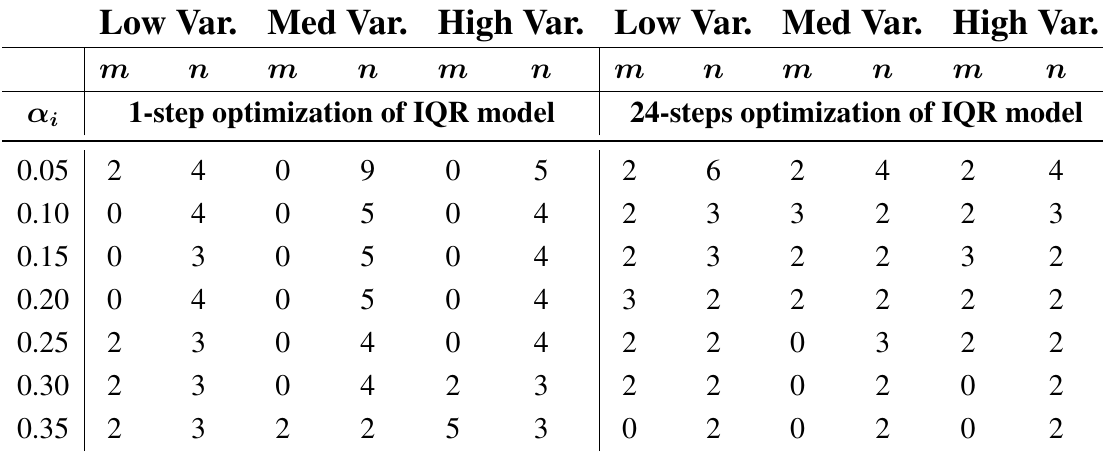
Table 4. 1-step and averaged over 24-steps CFS optimization results for the IQR model of Equation